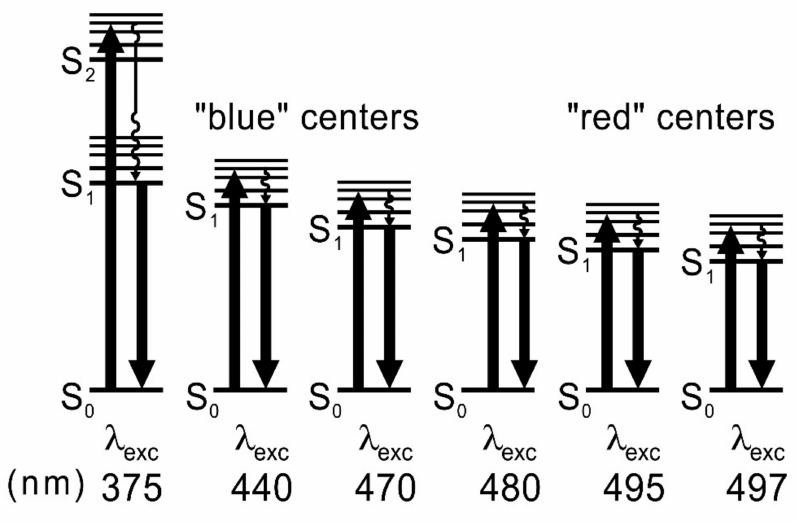
Figure 7. Scheme of the energy levels of “blue” and “red” FMN centers. Figure 8 shows exemplary fluorescence decays of FMN in PVA for C = 7 × 10 − 5 M, measured at excitation wavelengths from λ exc = 475 nm (excitation of “blue” centers) to λ exc = 497 nm (excitation of “red” centers) at the same observation wavelength of λ obs = 530 nm. Observed decays are clearly